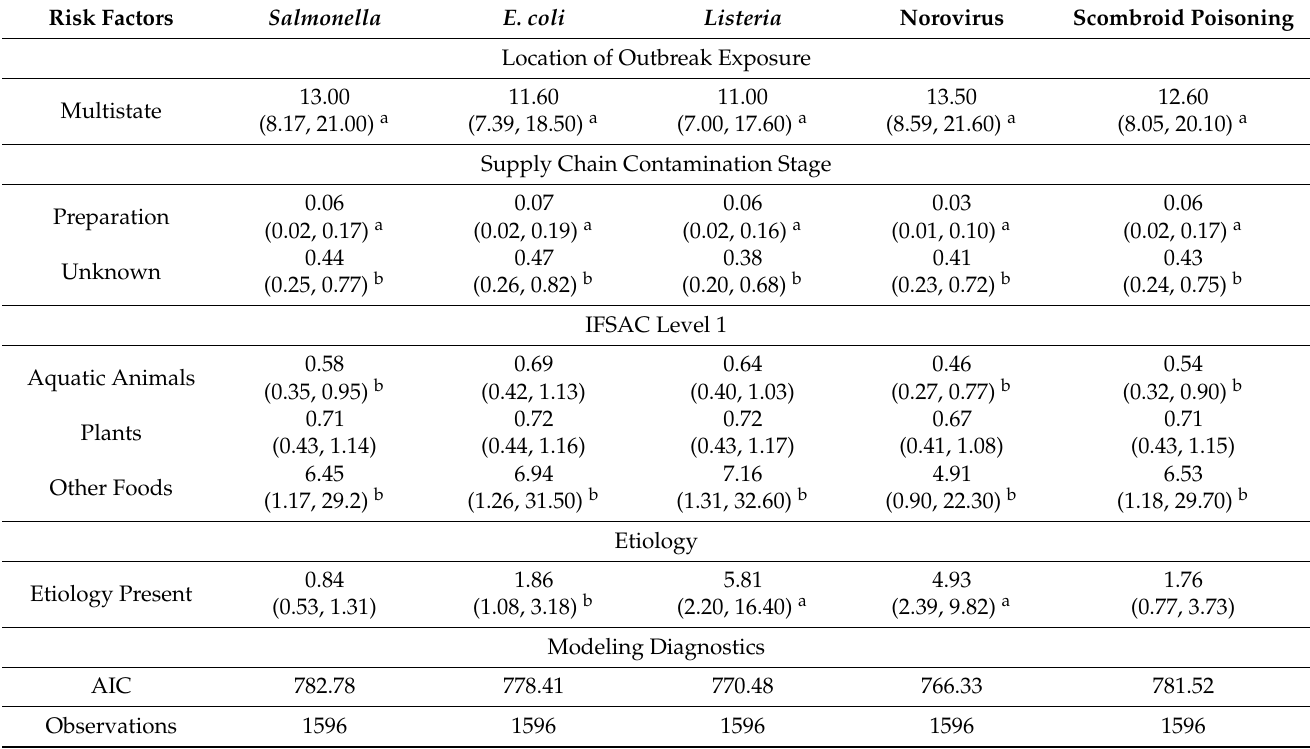
Table 5. Logistic regression results examining the likelihood of foodborne and waterborne outbreaks resulting in food recalls, as reported by the electronic Foodborne Outbreak Reporting System (eFORS) and National Outbreak Reporting System (NORS) in 1998–2019. We selected risk factors according to univariate logistic regression results and added factors in a stepwise order. Risk factors include multi- state exposure outbreaks (reference: single-state exposure outbreaks), supply chain contamination stage (reference: before-preparation stage), IFSAC Level 1 food categories (reference: land animals), and presence of a contaminant etiology (reference: absence of or unknown etiology). We report fully specified models for 5 contaminant etiologies, namely Salmonella , E. coli , Listeria , norovirus, and scombroid poisoning associated outbreaks. We report the odds ratio estimates (and 95% confidence intervals), Akaike’s Information Criterion (AIC), and the number of observations per